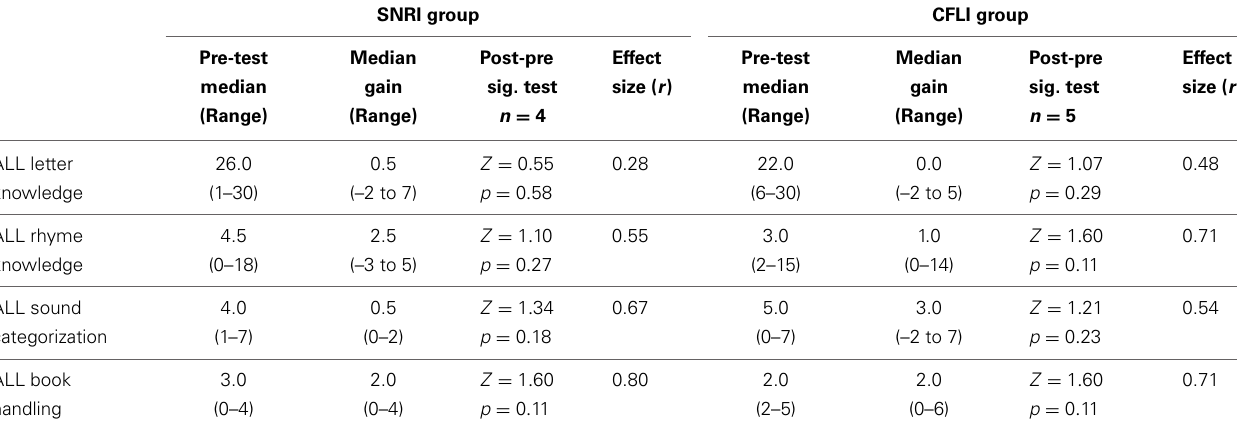
Table 3 | Pre- and post-test assessments of alphabet knowledge, phonological awareness, and print